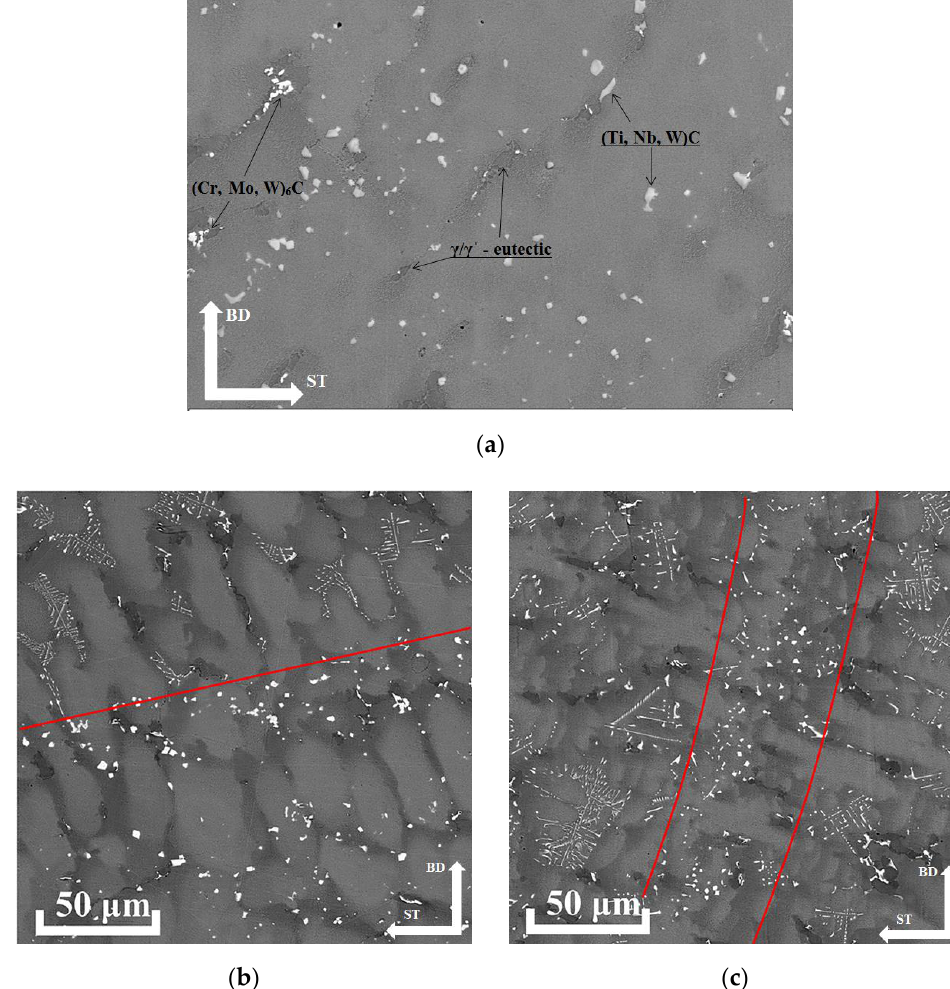
Figure 9. Microstructure of the product made of ZhS6U alloy after electron-beam additive process ( a ); ( b ) — layer boundary(red line): ( c ) — melt bath boundary (red line). ( a ); ( b )—layer boundary (red line); ( c )—melt bath boundary (red